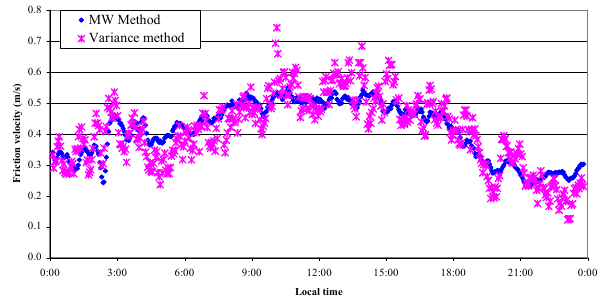
Fig. 7a. Friction velocity. Comparison between the statistical Figure 7.a: Friction velocity. Comparison between the statistical method MW and the variance method (Plot CT, 25 July 1997) method MW and the variance method (Plot CT, 25 July